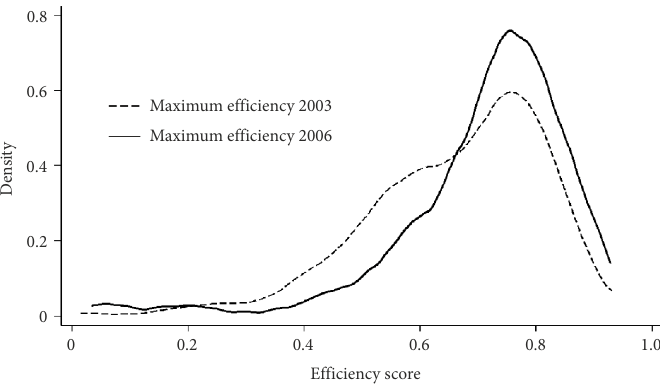
Fig. 5. Maximum efficiency for ICT manufacturing firms